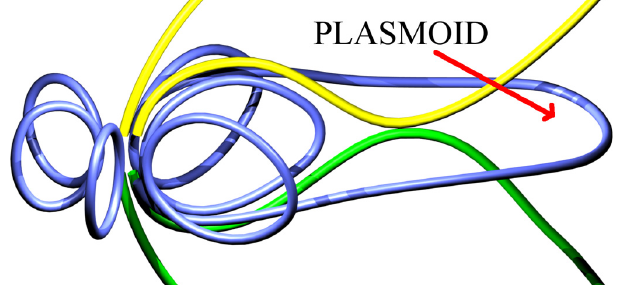
Fig. 1. A plasmoid forming inside the closed magnetic field line region in the y-plane. Original figure by D. P. Stern.